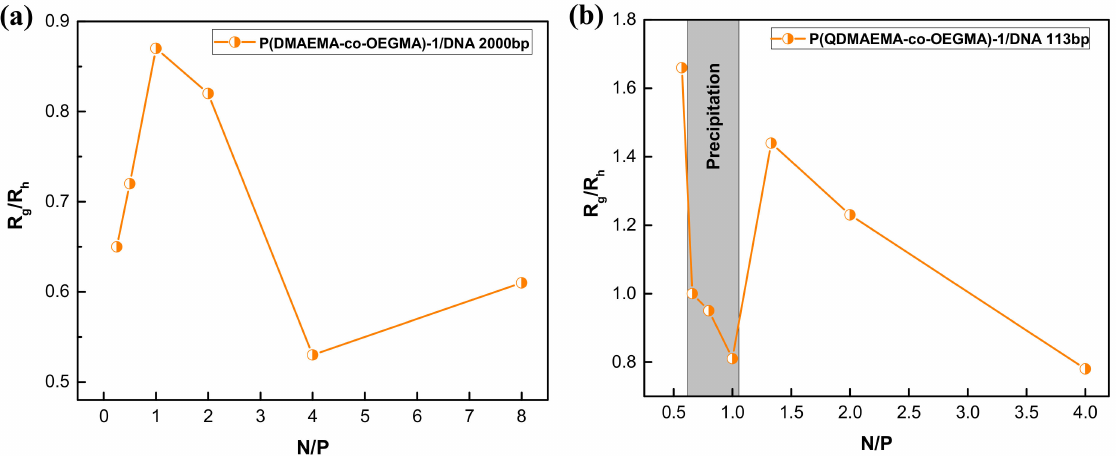
Figure 9. Variations of R g /R h ratio as a function of N/P ratio for ( a ) P(QDMAEMA-co-OEGMA)- 1/DNA 2000 bp and ( b ) P(QDMAEMA-co-OEGMA)-1/DNA 113 bp